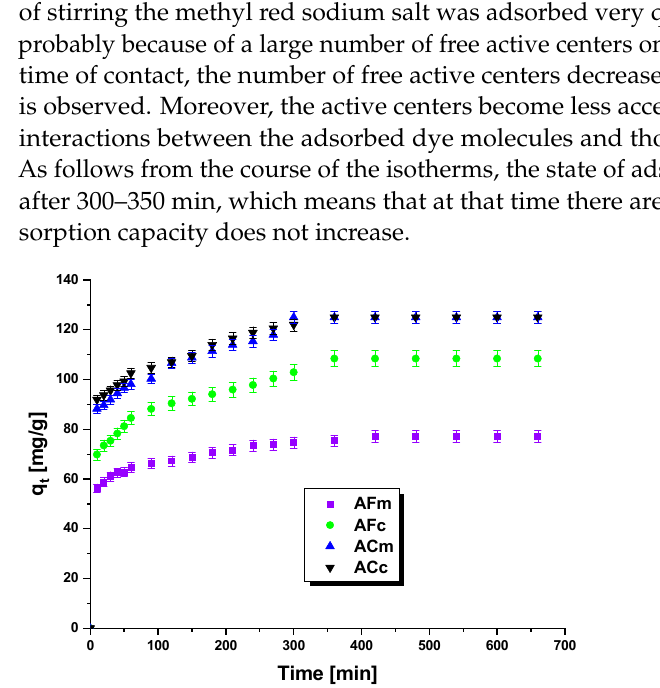
Figure 5. Influence of contact time on adsorption of methyl red sodium salt on biocarbons. The kinetics of methyl red sodium salt adsorption on the surface of the biocarbons